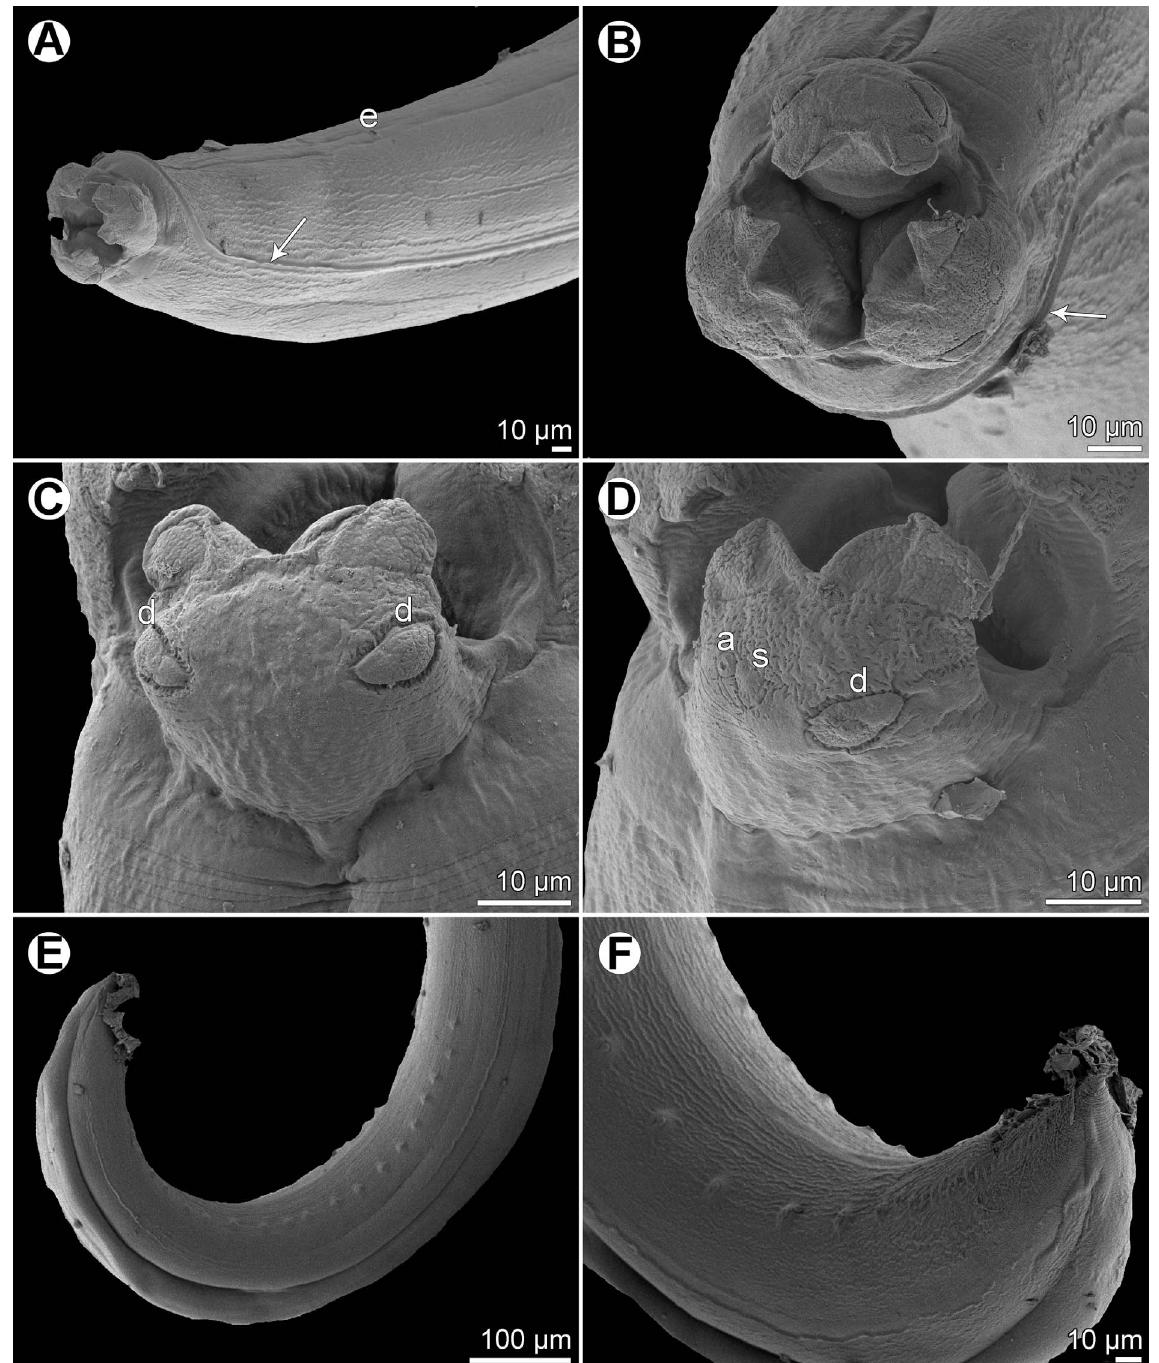
Figure 7. Raphidascaris ( Ichthyascaris ) nudicauda n. sp., scanning electron micrographs of male. (A) Anterior end of body, sublateral view (arrow indicates lateral ala); (B) cephalic end, apical view (arrow indicates lateral ala); (C) dorsal lip; (D) ventrolateral lip; (E) posterior end, sublateral view; (F) posterior end, ventrolateral view. (a) Amphid; (d) double papilla; (e) excretory pore; (s) single